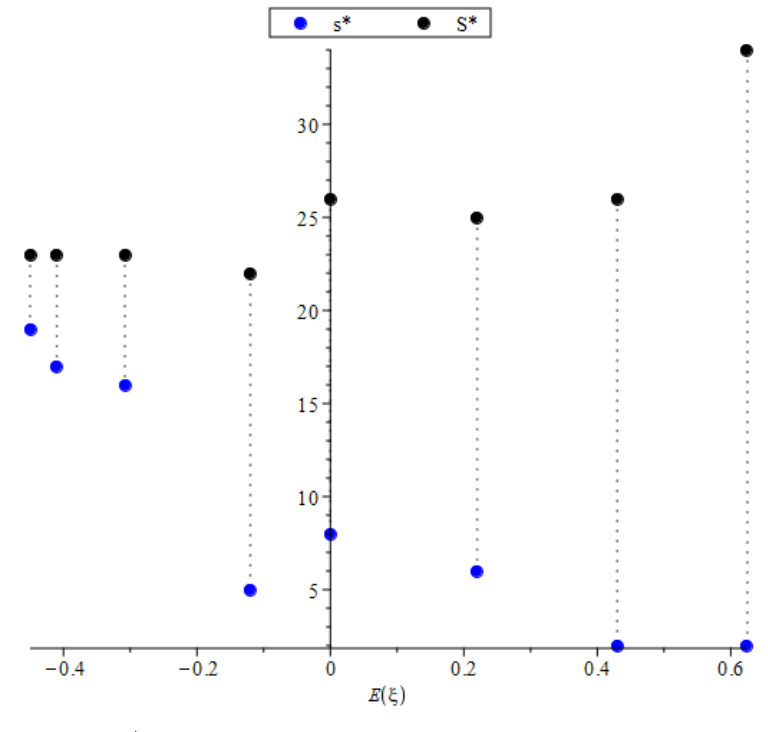
Figure 7. ( s ∗ , S ∗ ) corresponding to E ( ξ ) , Scenario 2.